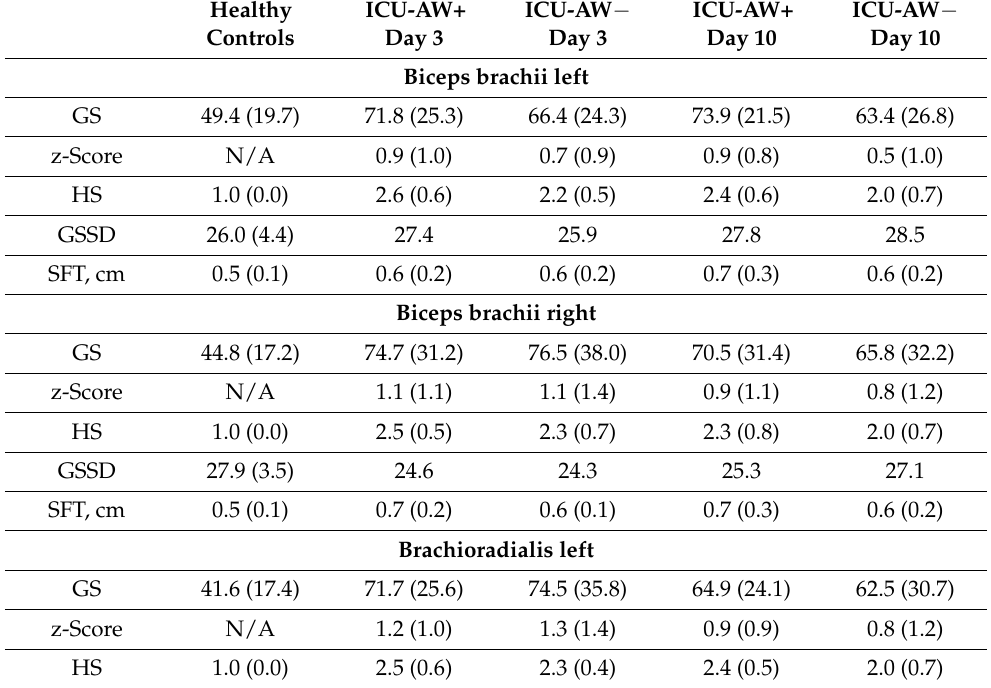
Table 2. Parameters of muscle echogenicity. Data presented as mean (standard deviation). Corre- sponding p values of group comparisons are available in Supplementary File S2. The results are rounded to the first decimal place. GS: greyscale value. GSSD: greyscale standard deviation. HS: Heckmatt scale. ICU-AW: intensive care unit-acquired weakness. N/A: value not available. SFT: subcutaneous fat layer